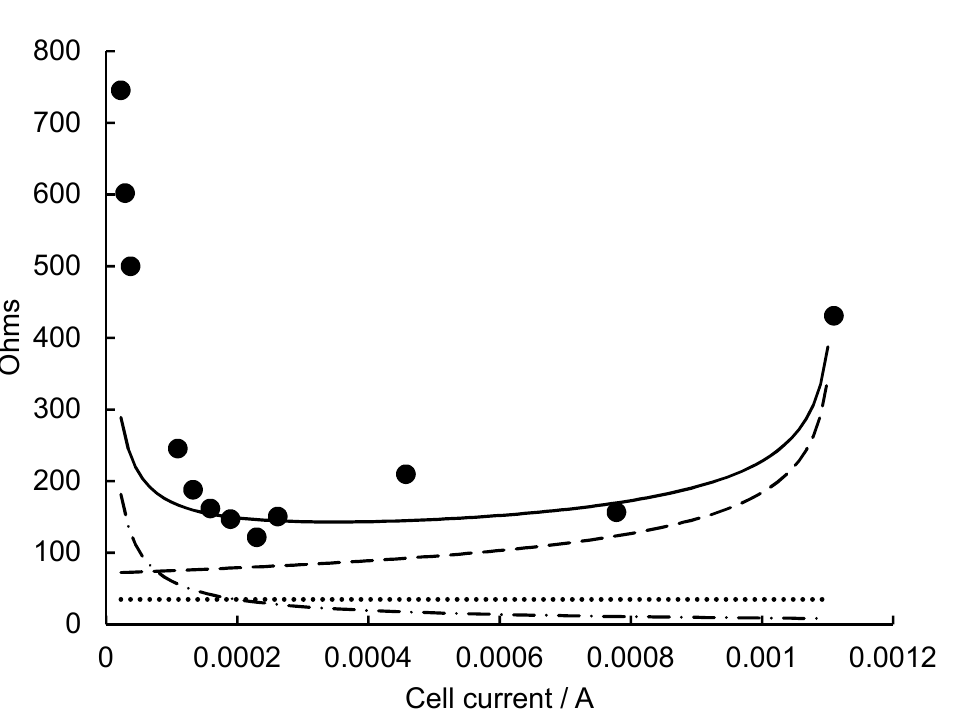
Figure 4. Variation of SMFC resistances at pH 6: experimental R i (  ) and the predictions of R i (solid line), R act (dashed dotted line), R conc (dashed line), and R ohmic (dotted line).